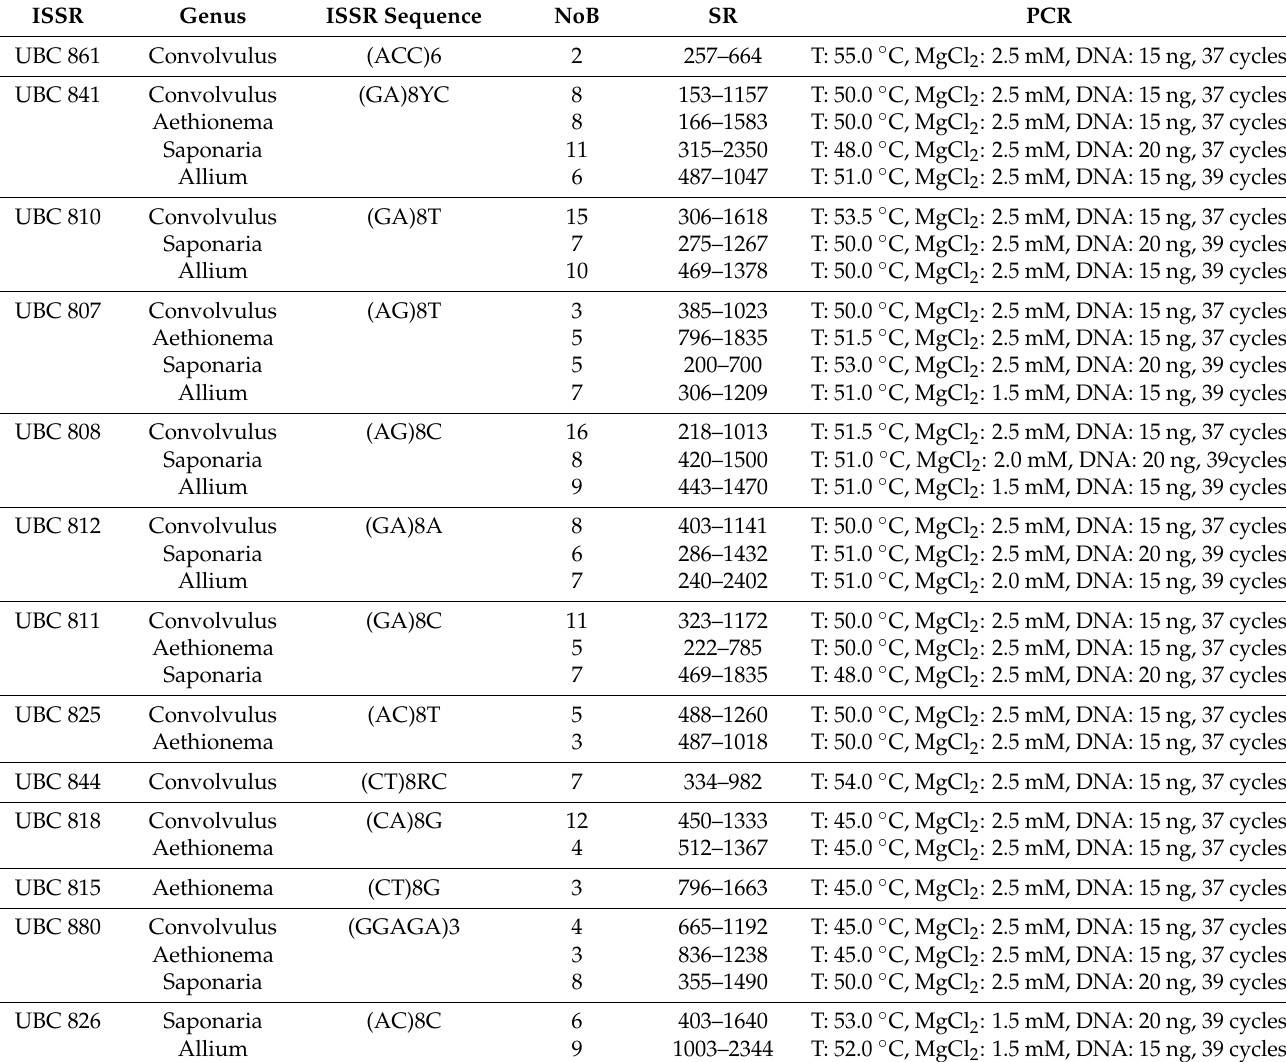
Table 2. ISSR primers that were successfully and repeatedly amplified per species, the sequence of each primer (ISSR sequence), the number of bands (NoB), and their size range (SR in base pairs), as well as the PCR conditions (anneal- ing temperature (T), MgCl 2 concentration, template, and number of cycles) used per marker and per species for the bands’